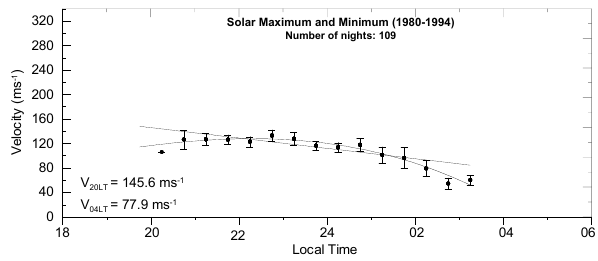
Figure 2. Same as Figure 1 except for the Solar Flux F10.7 cm parameter horizontal axis. The plasma bubbles zonal drift velocities were obtained in the interval between 18LT and 22:45LT .